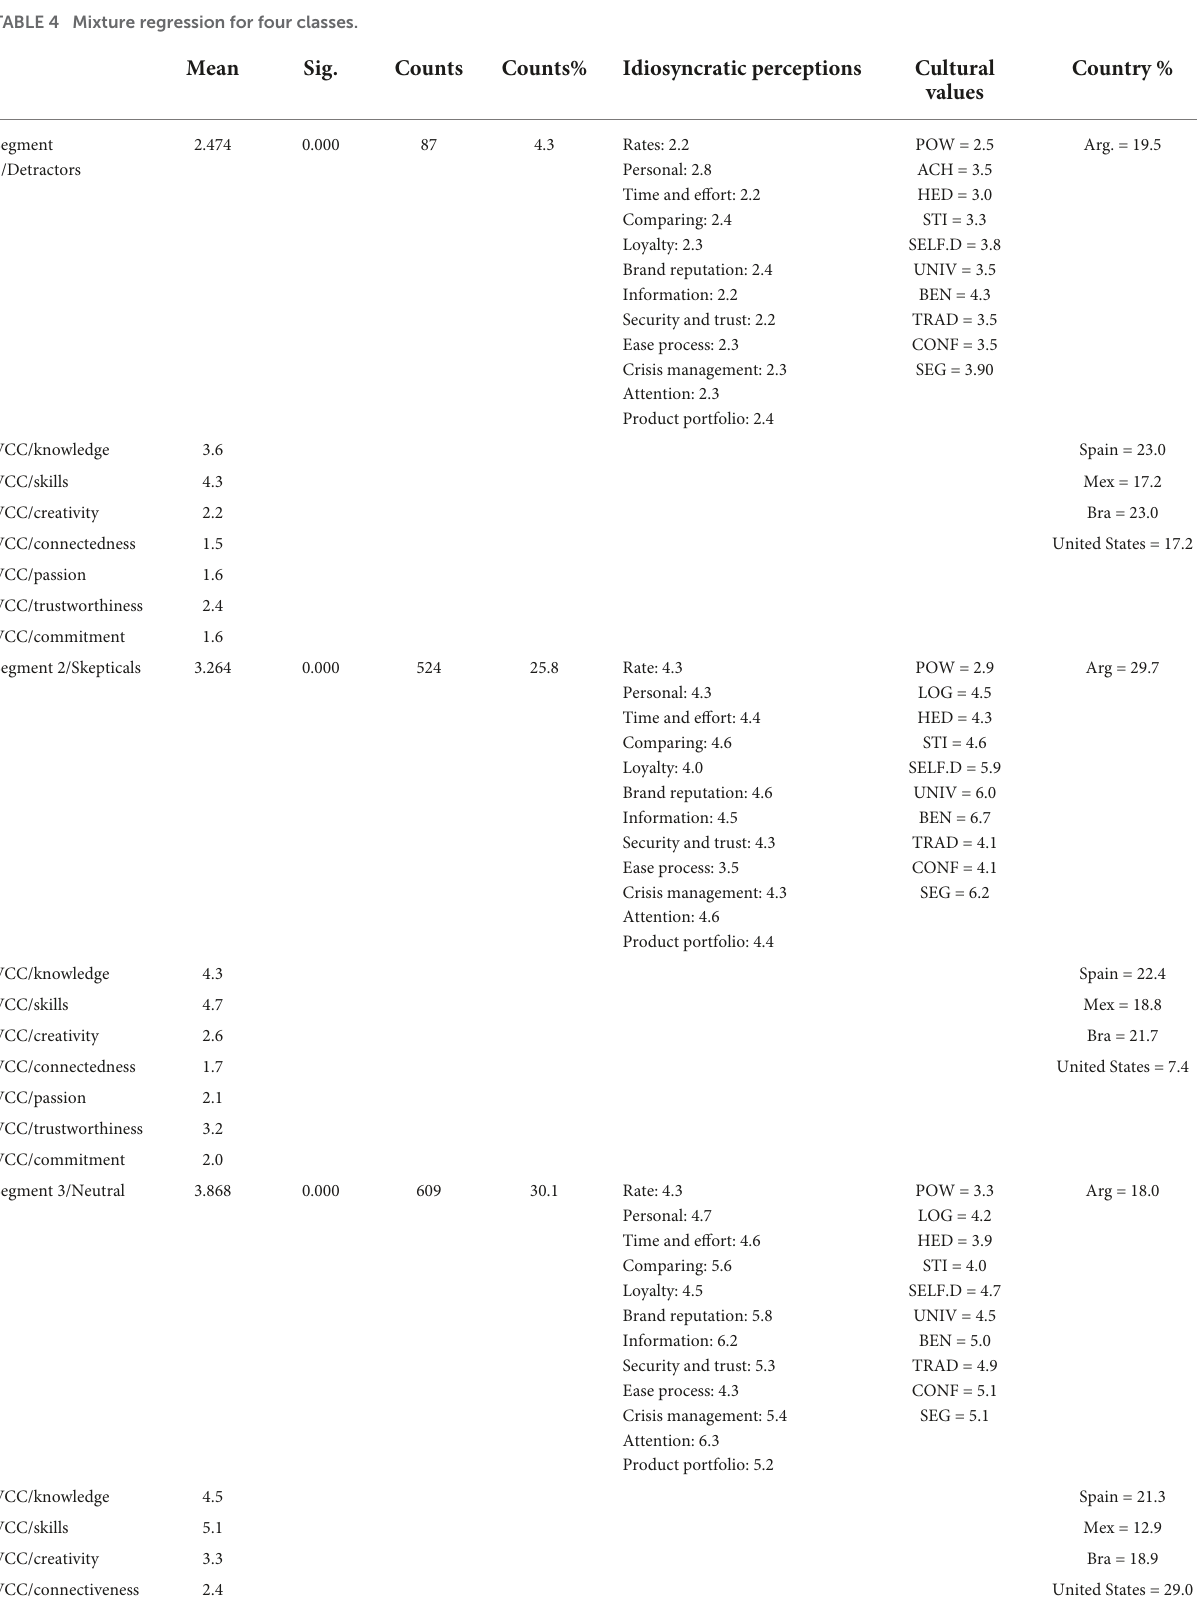
TABLE 4 Mixture regression for four